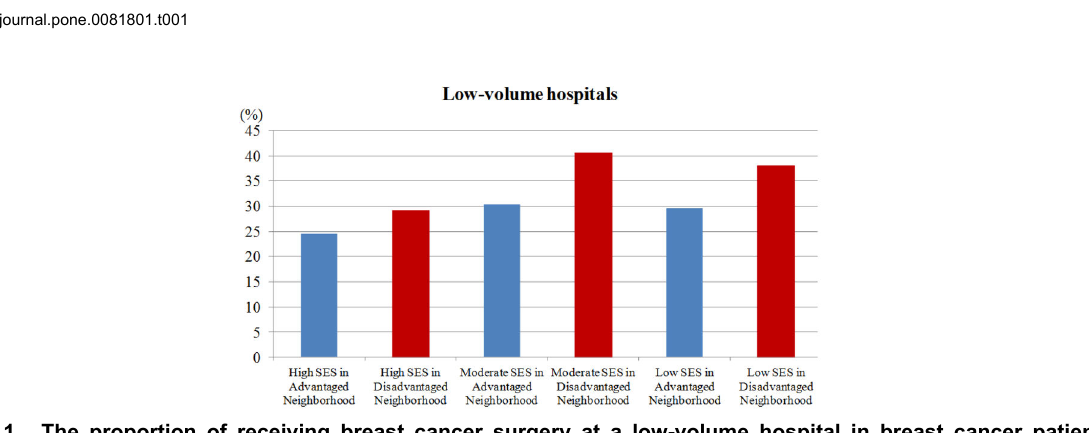
Figure 1. The proportion of receiving breast cancer surgery at a low-volume hospital in breast cancer patients by individual and neighborhood